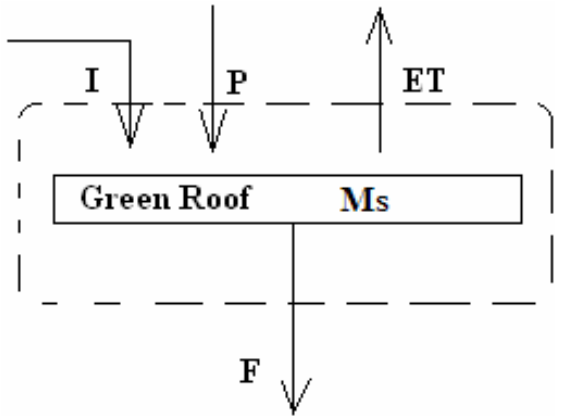
Figure 1. Green roof system boundaries [10]. The variables are as follows: M S = Media storage (volume/(unit area of green roof)); P = Precipitation (volume/(unit area of green roof × time)); I = Irrigation (volume/(unit area of green roof × time)); ET = Evapotranspiration (volume/(unit area of green roof × time)); F = Filtrate (volume/(unit area of green roof ×